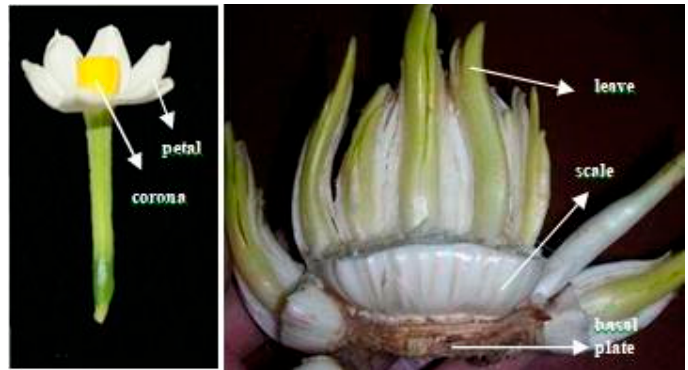
Figure 8. Different tissues and organs of Chinese narcissus used in this experiment. Figure 8. Di ff erent tissues and organs of Chinese narcissus used in this